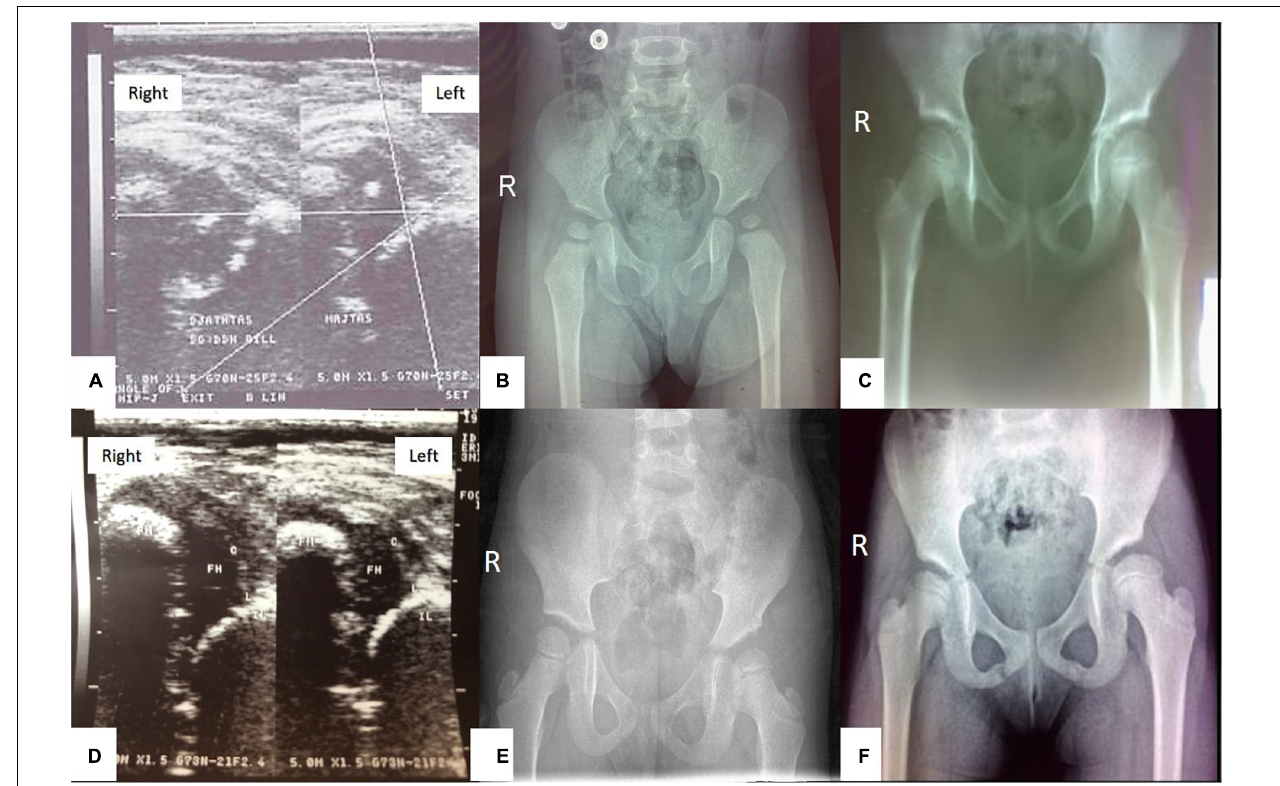
FIGURE 3 | A baby girl with left hip dislocation undergoing closed reduction under analgesia and sedation (A–C), and a baby girl with bilateral hip dislocation undergoing closed reduction under general anesthesia (D–F) : (A) Ultrasound examination of the hips at the age of 4.9 months showing left hip dislocation type IIIb according to Graf’s classification; (B) radiography of the hips at the age of 20 months, showing AVN type I of the left femoral head according to Ogden and Bucholz classification- hypoplastic epiphysis of the proximal femur; (C) radiography of the hips at the age of 7.9 years showing complete improvement of ossification of the left femoral head. (D) Ultrasound examination of the hips at the age of 3.9 months showing bilateral hip dislocation type IV according to Graf’s classification; (E) Radiography of the hips at the age of 2.4 years showing AVN type II of the left femoral head according to Ogden and Bucholz classification with overgrowth of greater trochanter into valgus, lateral metaphysis shows evidence of injury; (F) radiography of the hips at the age of 7.6 years showing AVN type II of the left femoral head according to Ogden and Bucholz classification – overgrowth of greater trochanter into valgus.